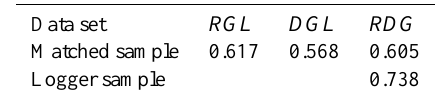
Table 6. AUROC values expressing the ability of ATI to discrim- inate between different ice-debris accumulations and other debris